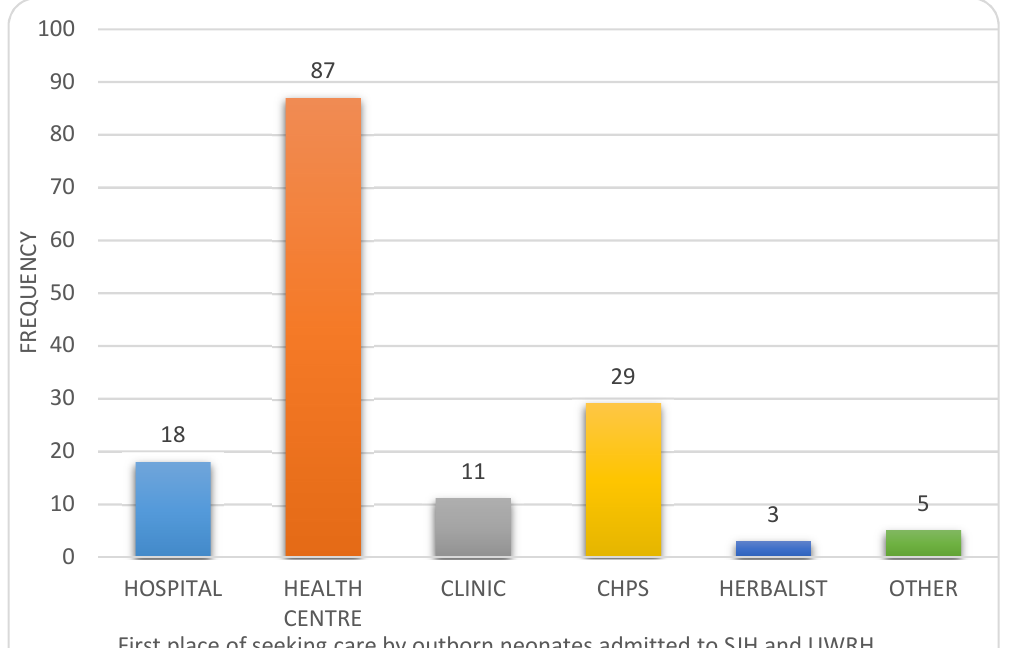
Figure 3. The first place of seeking care by outborn neonates.